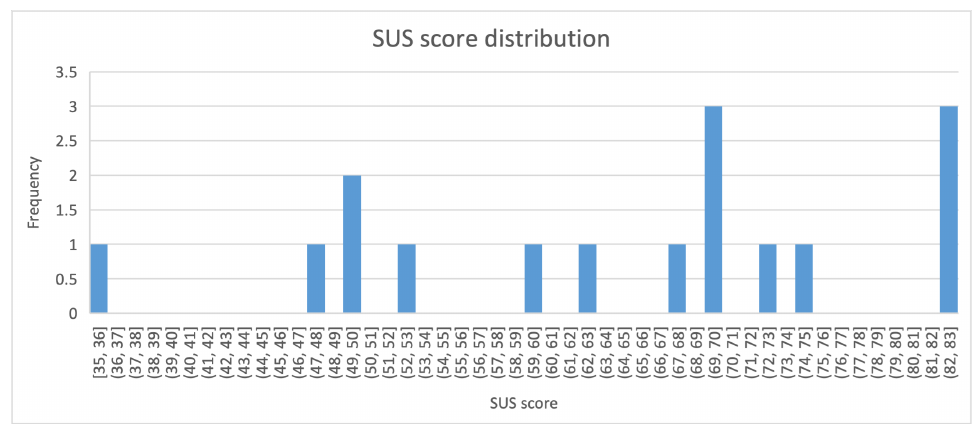
Figure 22. SUS scores of the interface developed for the analysis of water stress and irrigation requirements use case. The X-axis indicates a certain range of the score. The Y-axis indicates the number of participants who gave the score within the range.